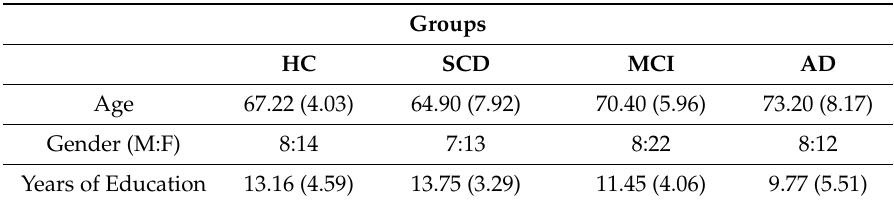
Table 1. The table presents mean ± SD (standard deviation) of demographic characteristics among participants (HC = 22, SCD = 20, MCI = 30, AD =